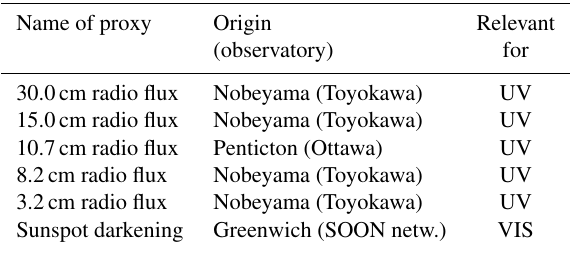
Table 2. Proxies used in addition to the original SSI data in order to fill in data